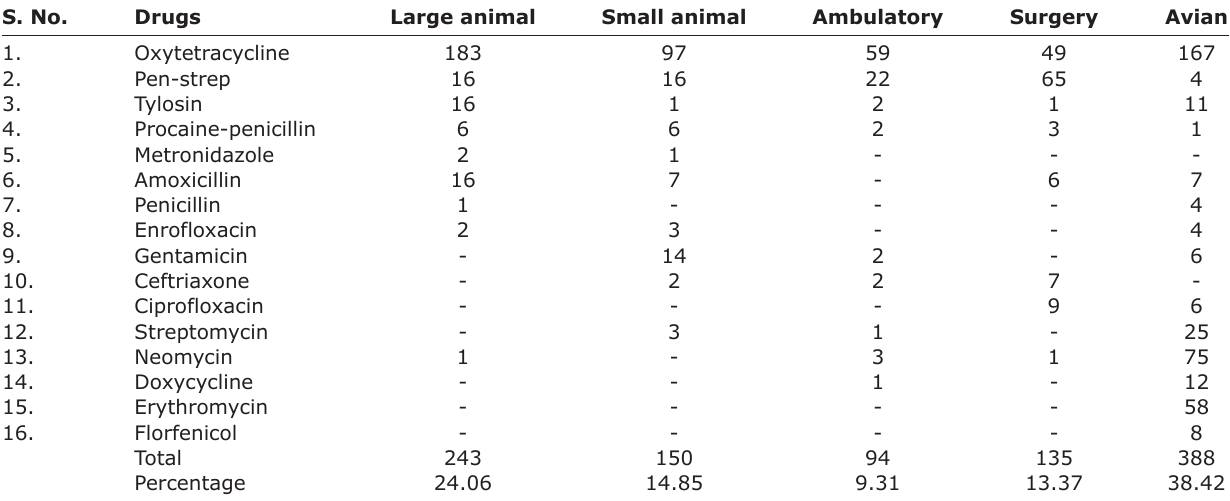
Table-1: Frequency of use of each drug in each unit of the UMVTH. S. No.